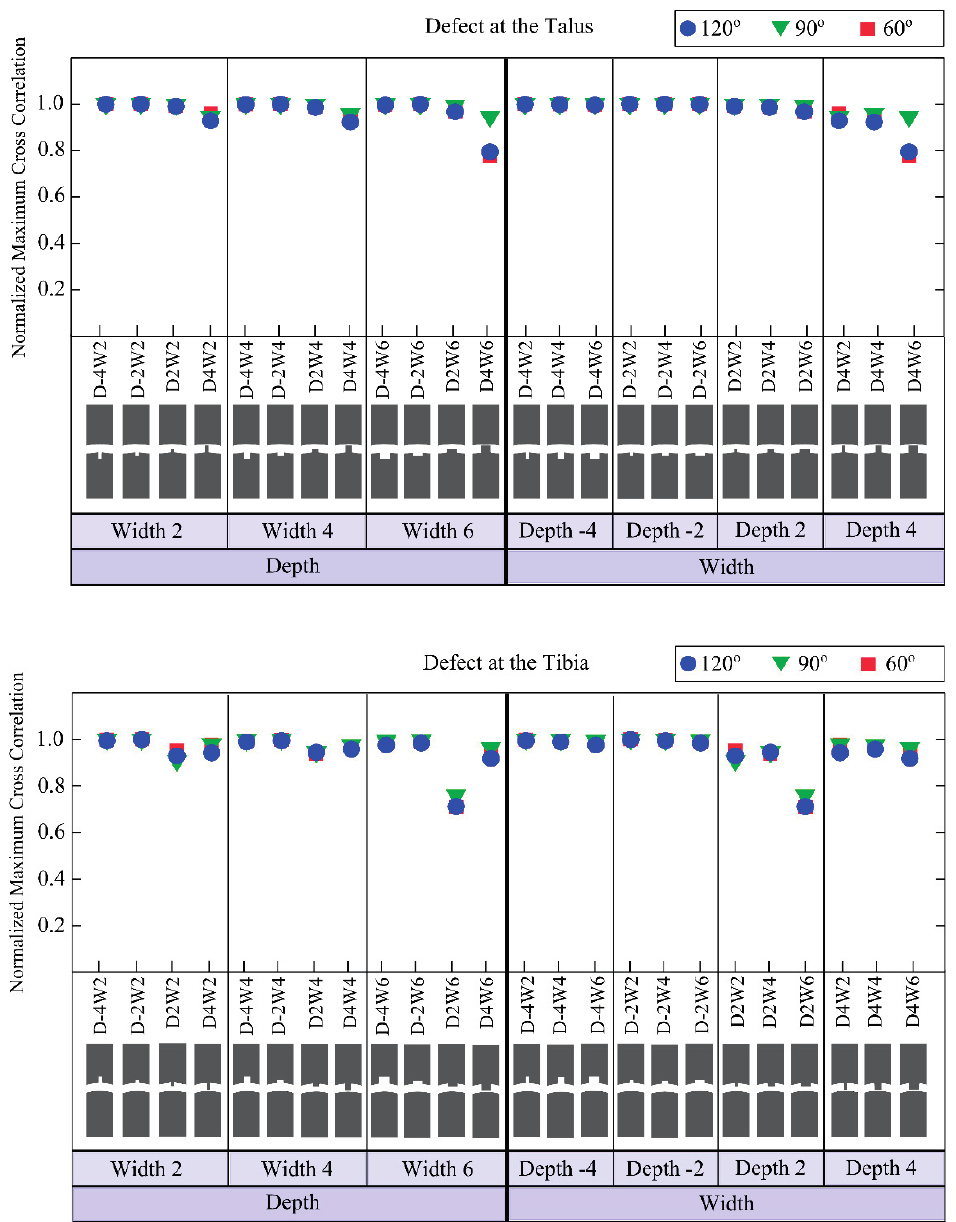
Figure 9. Normalized maximum cross correlation (NMCC) for models simulating defects located on the talus ( i.e. , first graph) and on the tibia ( i.e. , second graph). The first three columns of the first and second graphs are provided to clearly represent the effects of varying defects depths when the defect width was fixed at 2 mm, 4 mm or 6 mm. The last four columns are presented to easily capture the changes related to the varying defects widths when the defect depth was fixed at − 4 mm, − 2 mm, 2 mm or 4 mm. Negative values for defect depth are used to represent actual holes in the bone, while positive values are used to describe positive defects, which may occur in the stage IV lesions ( i.e. , detached and displaced osteochondral fragment). In the first and second graphs, depth and width of defect are represented by a “D” and a “W”, respectively. The minus sign “-” is used to describe negative defect, an actual hole in the bone (e.g., D-2W6 represents negative defect, i.e. , a hole, with a depth of 2 mm and a width of 6